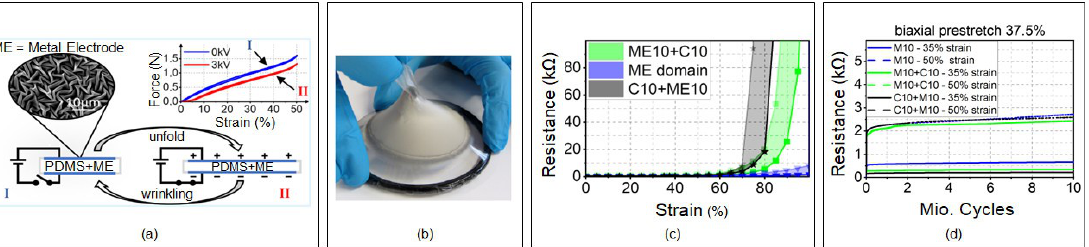
Figure 7. Single element DEA with Ni-sputtered nano-scale electrode ( a ), strong adhesion between electrode and silicone membrane ( b ), low resistance over large strain range ( c ), high cycle fatigue with stable resistance behavior ( d